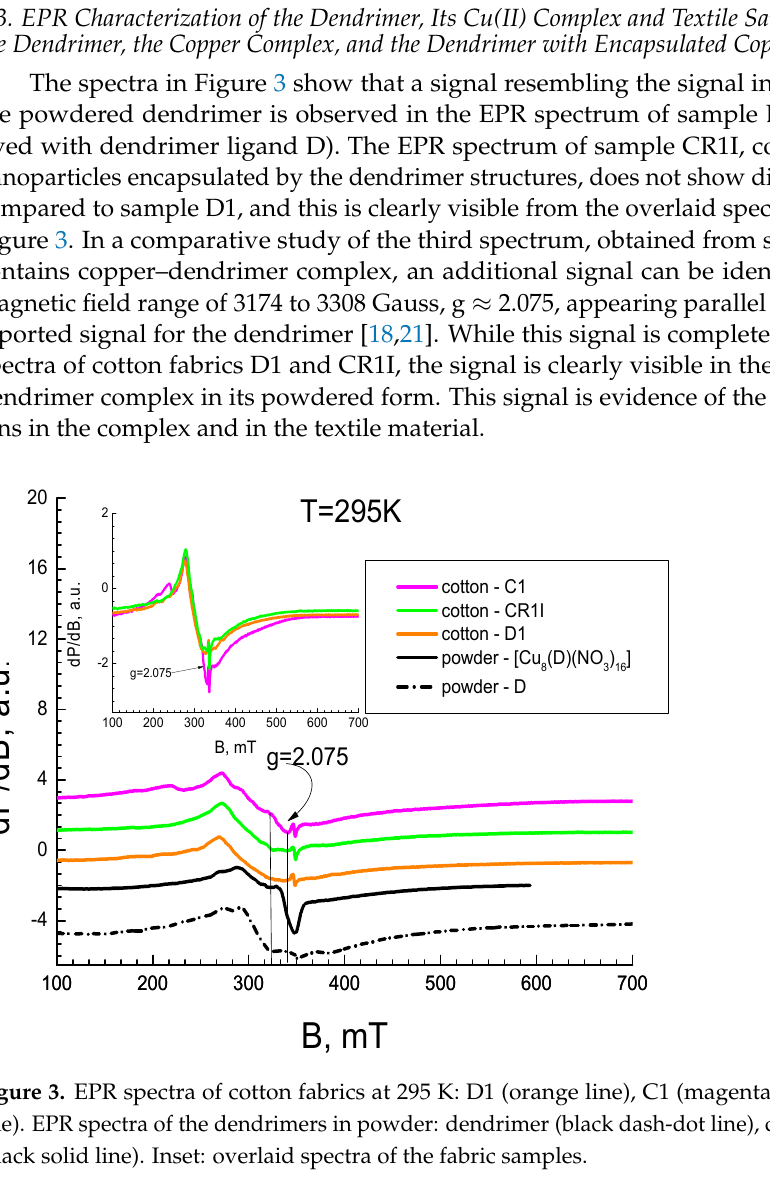
8 (D)(NO 3 ) 16 ] (( B , C ) at different magnifications).